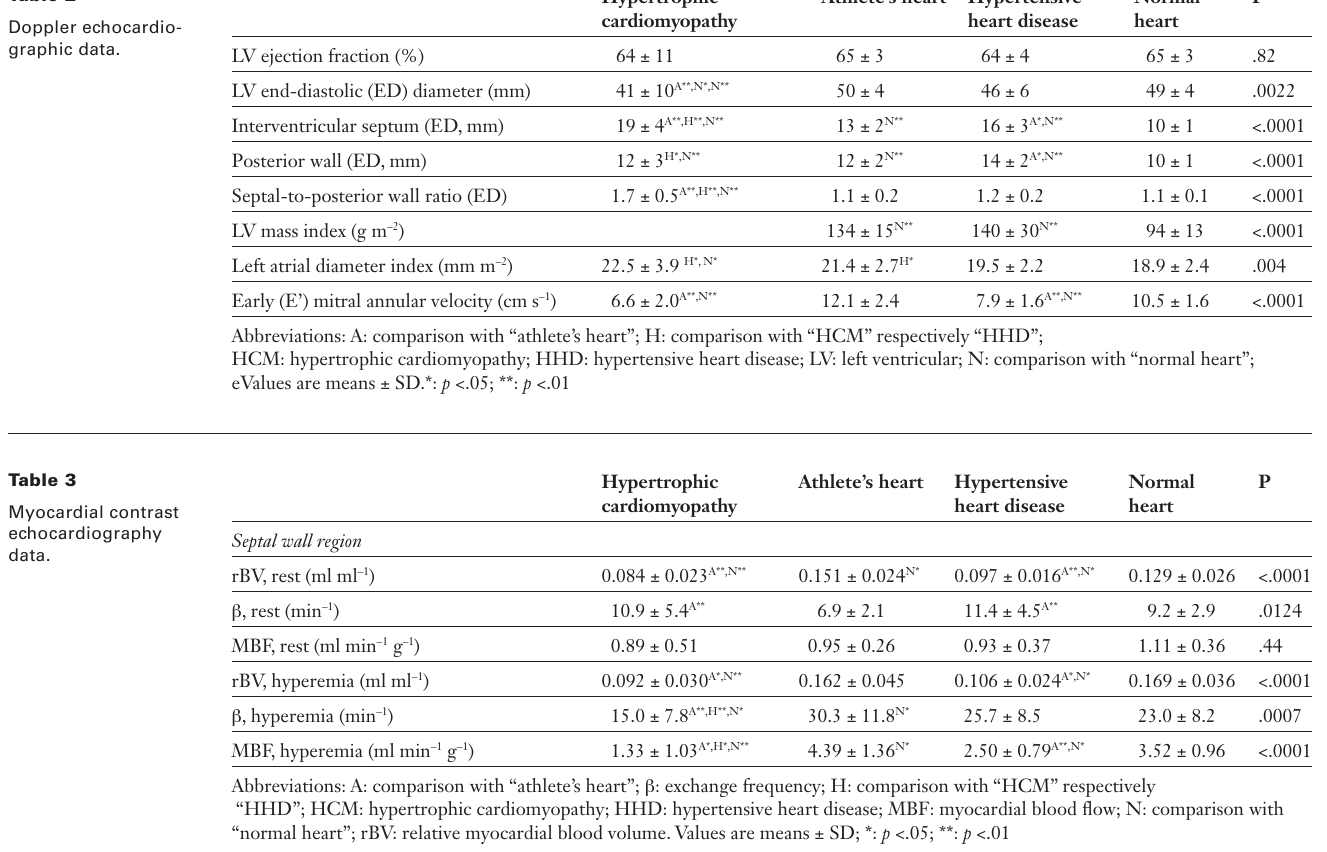
Figure 1 Individual data of septal myocardial blood flow (MBF, ml min –1 g –1 ) at rest (A) and during adeno- sine-induced hyper- aemia (B) in patients with hypertrophic cardiomyopathy (HCM; n = 15) with left ventricular hyper- trophy (LVH), in semi- professional triath- letes with LVH (n = 15), in hyperten- sive patients with LVH (n = 15), and in healthy, sedentary individuals without LVH (n = 15). The squared symbols with error lines indi- cate mean values ± standard